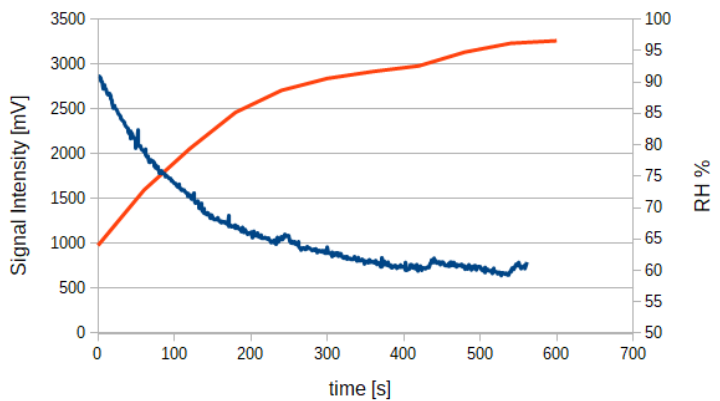
Figure 7. Optical signal intensity (blue) versus relative humidity